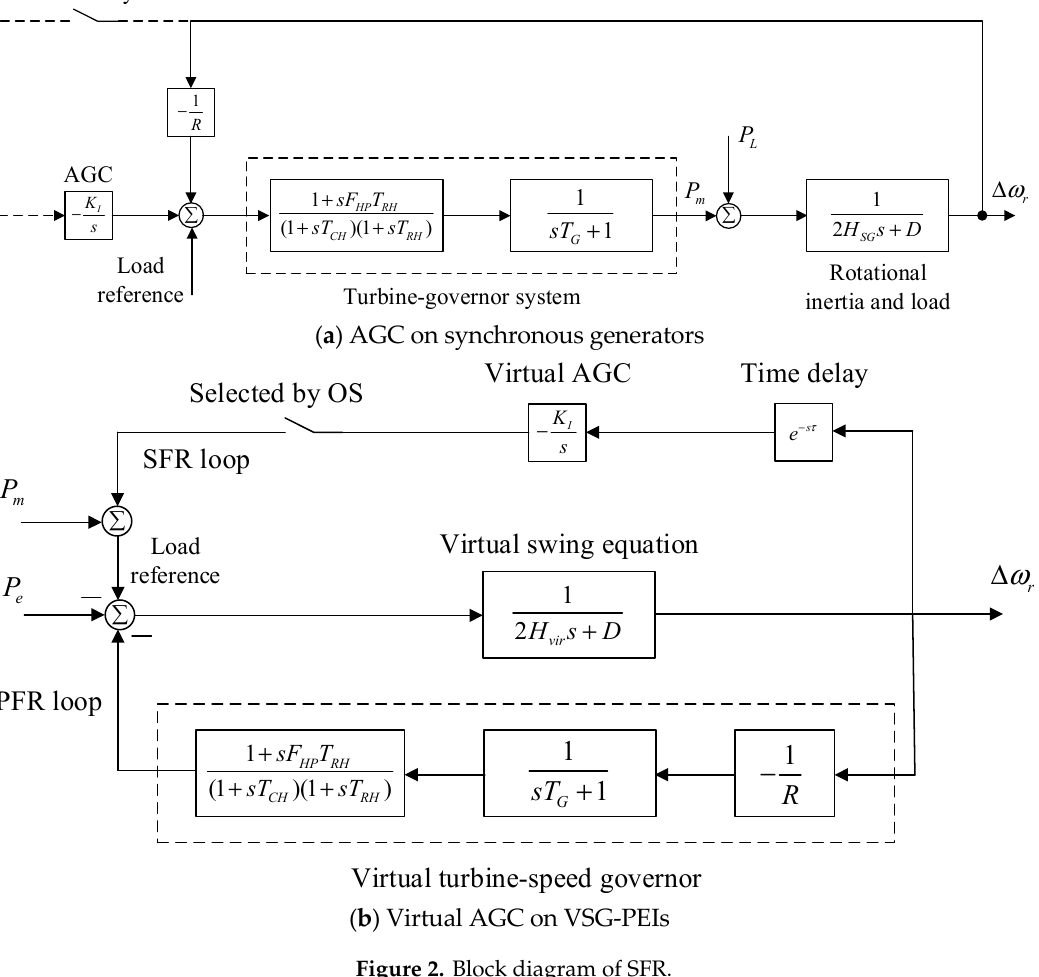
Figure 2. Block diagram of SFR.